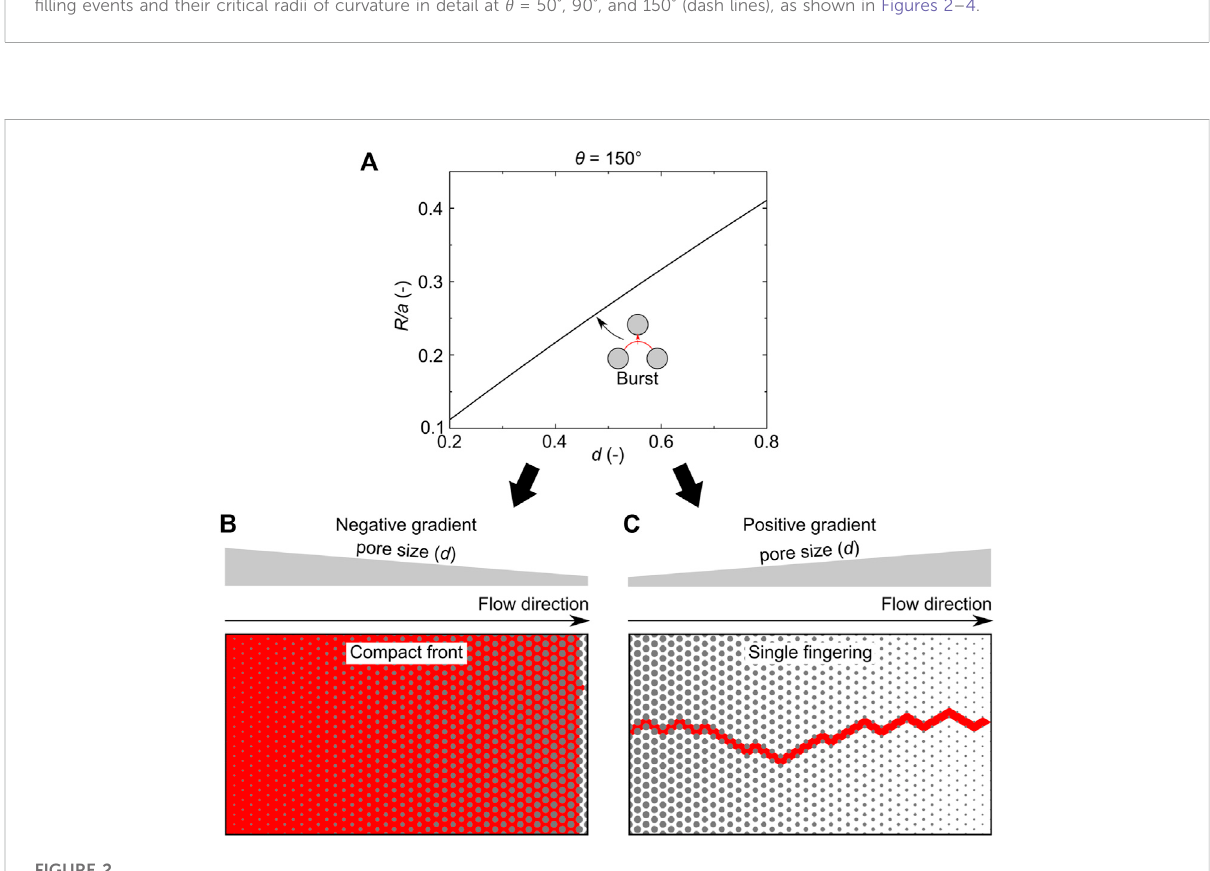
FIGURE 2 Linking pore- fi llingevents to localinvasionmorphologies at θ =150 ° . (A) Normalized critical radiusof curvature R / a oftheburstevent increases with the pore size. (B) In negative gradient porous media, the curvature radius of the burst event decreases along the fl ow direction, leading to a compact front. (C) In positive gradient porous media, the curvature radius of the burst event increases along the fl ow direction, leading to a single fi